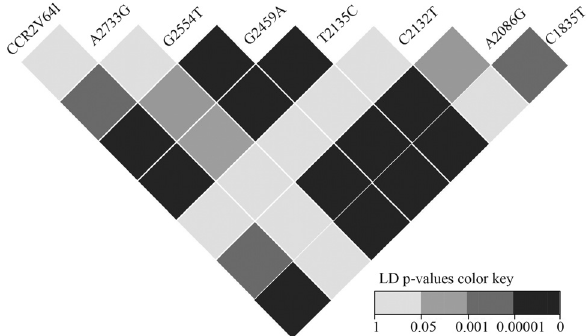
Figure 1 - Pairwise linkage disequilibrium results among SNPs. Colored boxes indicate significance levels of the chi-square test (light grey p > 0.05; grey: 0.001 < p < 0.05; dark grey: 0.0001 < p < 0.001 and black: p <